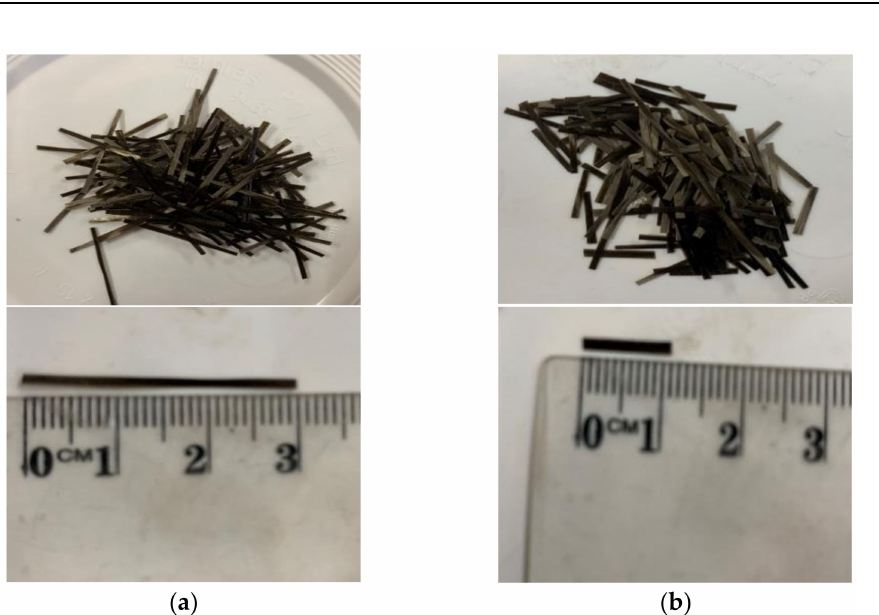
Figure 1. Short/long basalt fibres with ( a ) 30 mm and ( b ) 12 mm were used in the SCGC